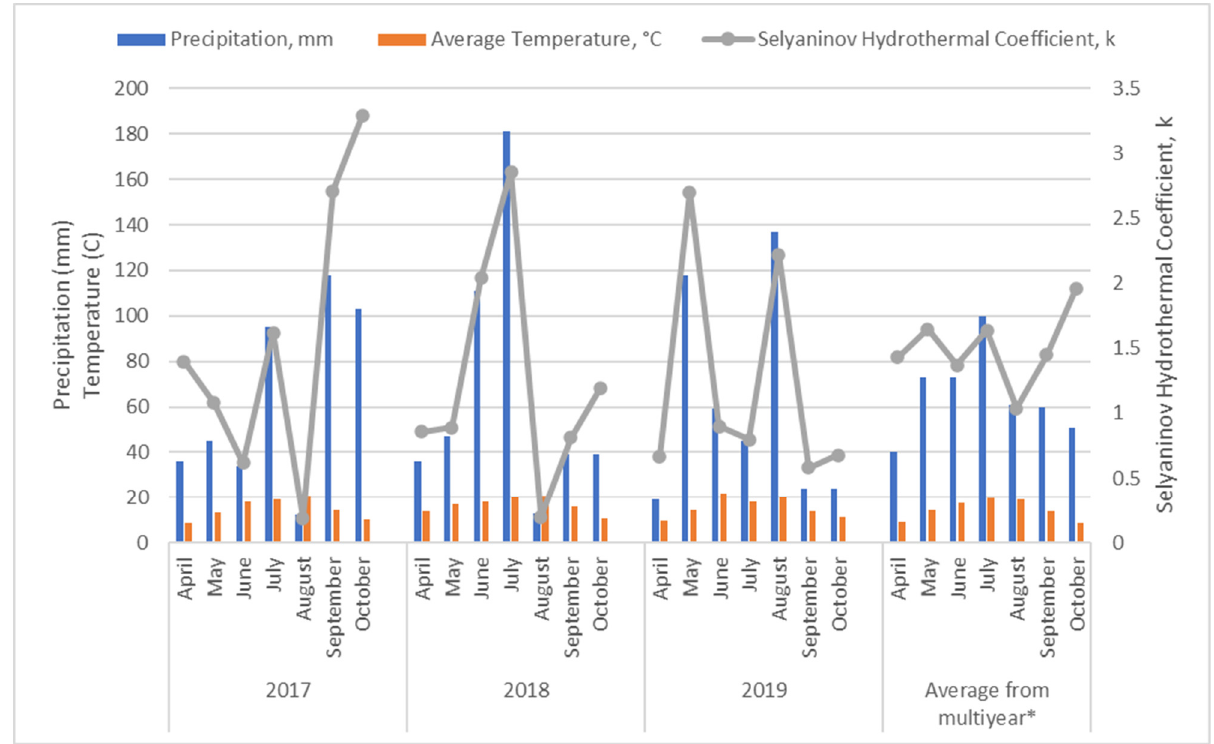
Figure 1. Temperature (in °C), precipitation (in mm) and Selyaninov Hydrothermal Coefficient during the growing season of sugar beet (2017–2019). * Precipitation: 1991–2019, Temperature: 2002–2019. Source: data from meteorological station located in Strzy ż ów Sugar Factory, geographical coordinates: 50°50 ′ 30” N 24°02 ′ 03” E.